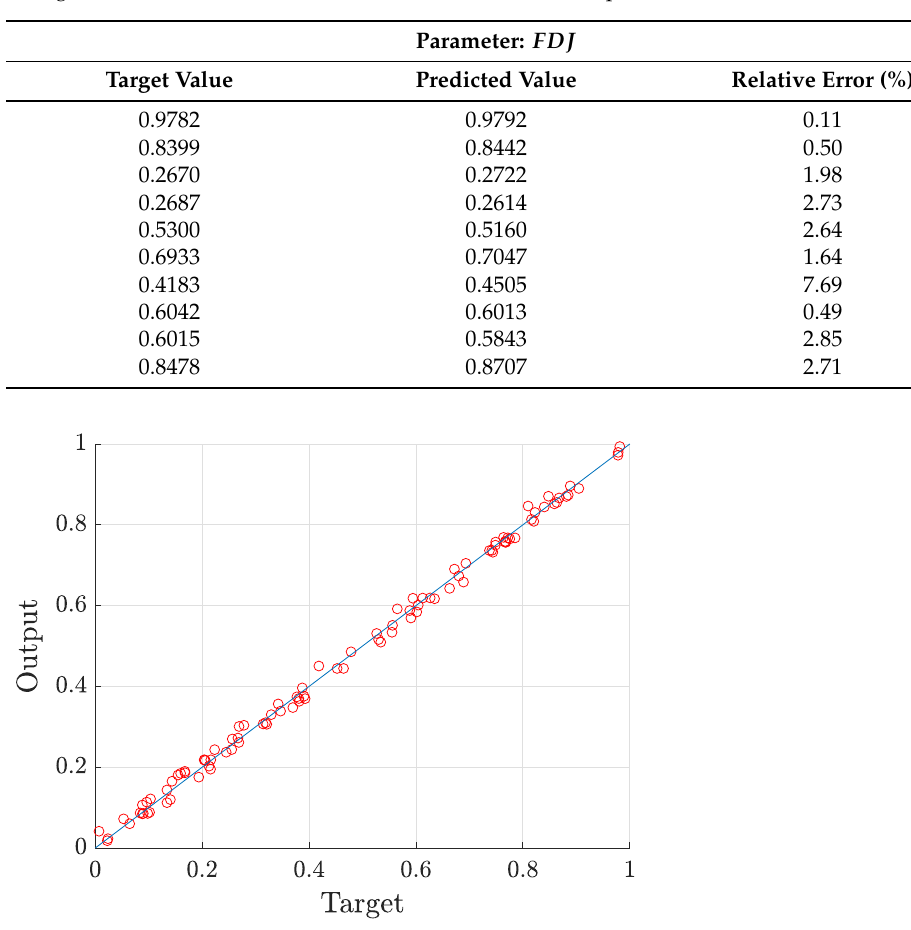
Table 3. Validation for Case A. Ten random predicted values were confronted with their actual value (“Target value”) in order to calculate the relative error of the prediction.